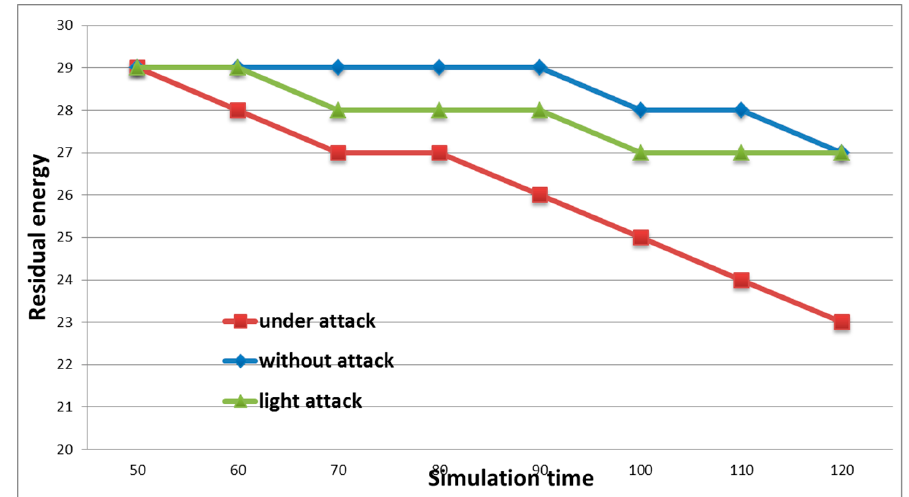
Figure 3. The variance of the load parameter D Lg for nodes under denial of service (DoS) attack with various numbers of victims.